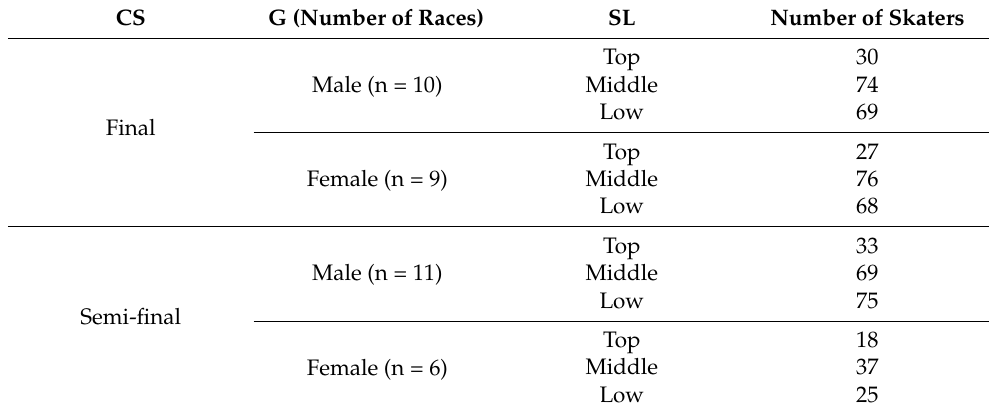
Table 1. SamplefromtheWorldCupandWorldChampionshipsduringthe2018–2019and2019–2020seasons. CS G (Number of